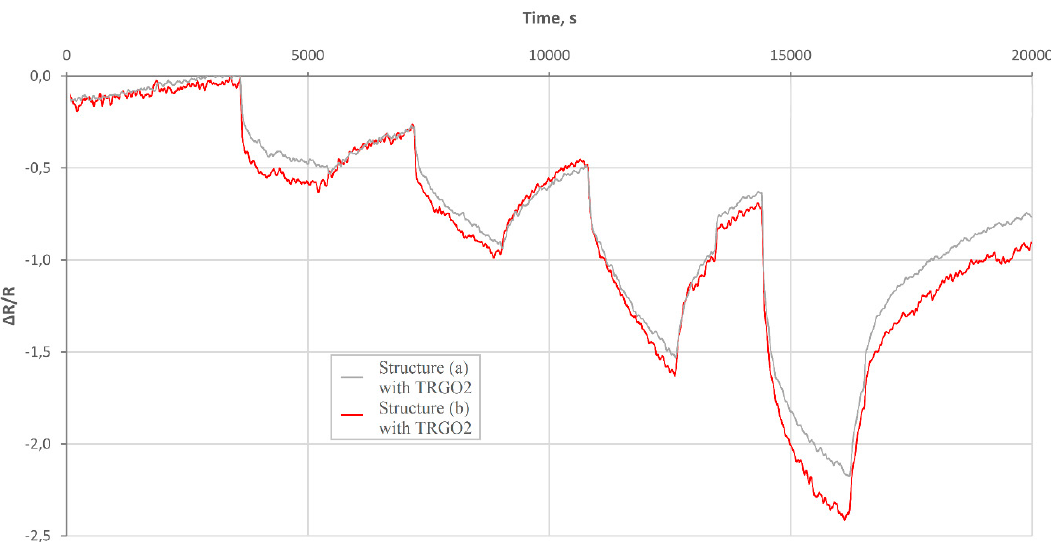
Figure A7. An exemplary response of two samples (with the same thermally reduced graphene: TRGO2) vs. time, temperature: 150 °C.